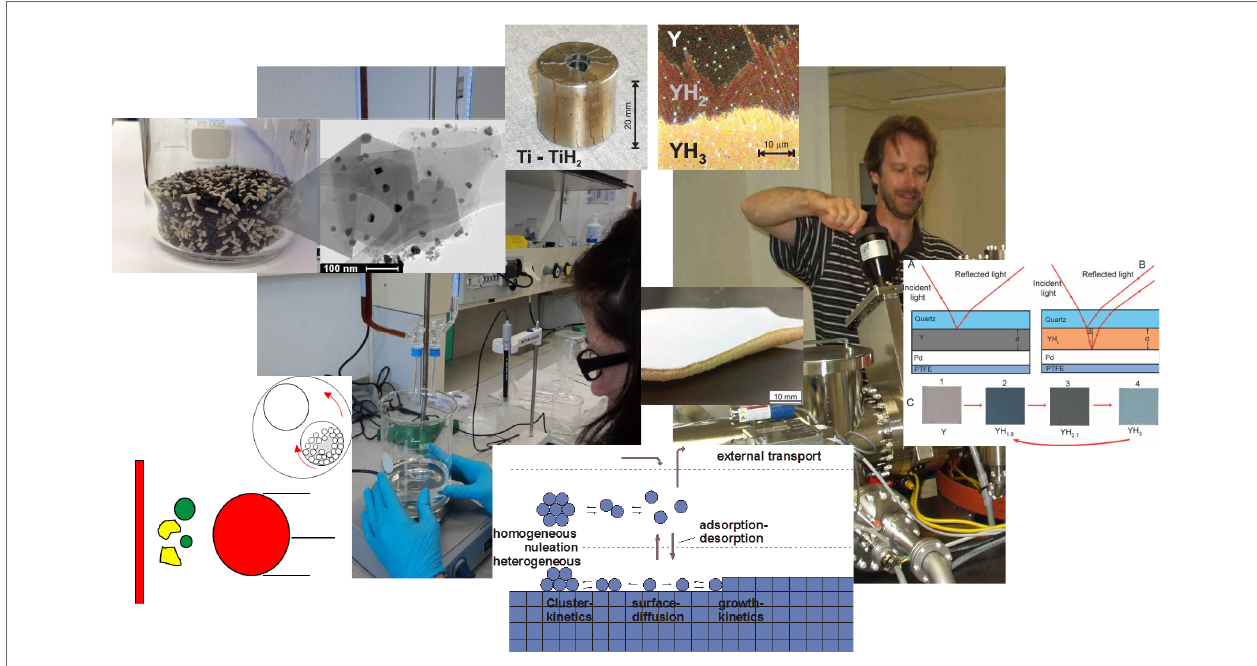
FiGUre 3 | Materials science is only limited by the creativity of the researchers: materials for hydrogen economy may be prepared by mass production methods such a wet chemistry and ball-milling (left side) as well as sophisticated thin film methodologies (right side) . Many catalysts (here Ni-particles in a zeolite matrix, left top picture) are prepared by wet chemistry, while ball-milling (left bottom sketch) is a common method for hydrogen storage materials. Thin film preparation such as sputtering (right background picture) is perfectly suited for 2D-devices such as sensors (right picture) and facilitates the investigation of the growth mechanisms and atomistic phenomena (middle bottom sketch), which define the resulting materials properties both for wet chemistry as well as physical deposition. Thin films can stabilize systems suffering from hydrogen-induced mechanical stress (top middle figures: mechanical deformation of bulk Ti after hydrogenation, similar stress is induced in yttrium hydride films, but they are kept stable due to adhesion to the substrate). Membranes (middle photo) and electrodes are commonly prepared by wet chemistry methods as well as thin film deposition